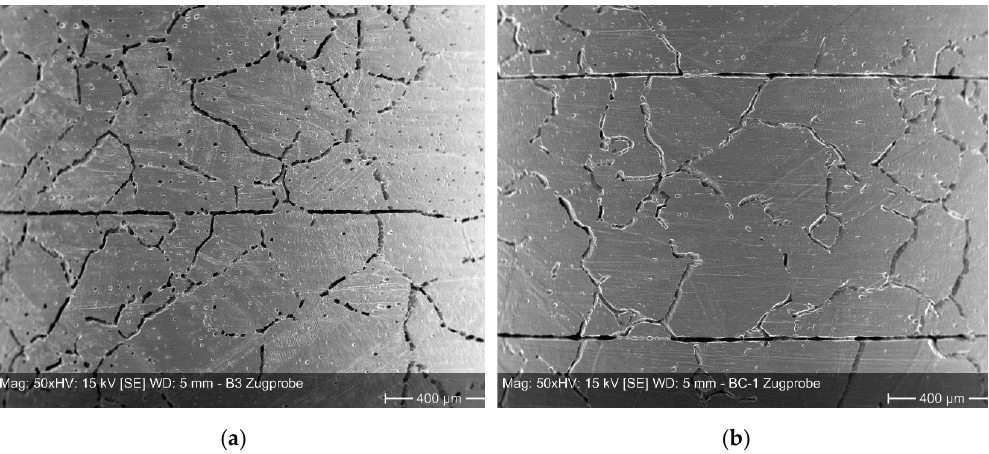
Figure 6. Surface of tensile specimens from Hastelloy B3 ( a ) and Hastelloy BC-1 ( b ) after exposure to 70% sulfuric acid at 100 °C for 1000